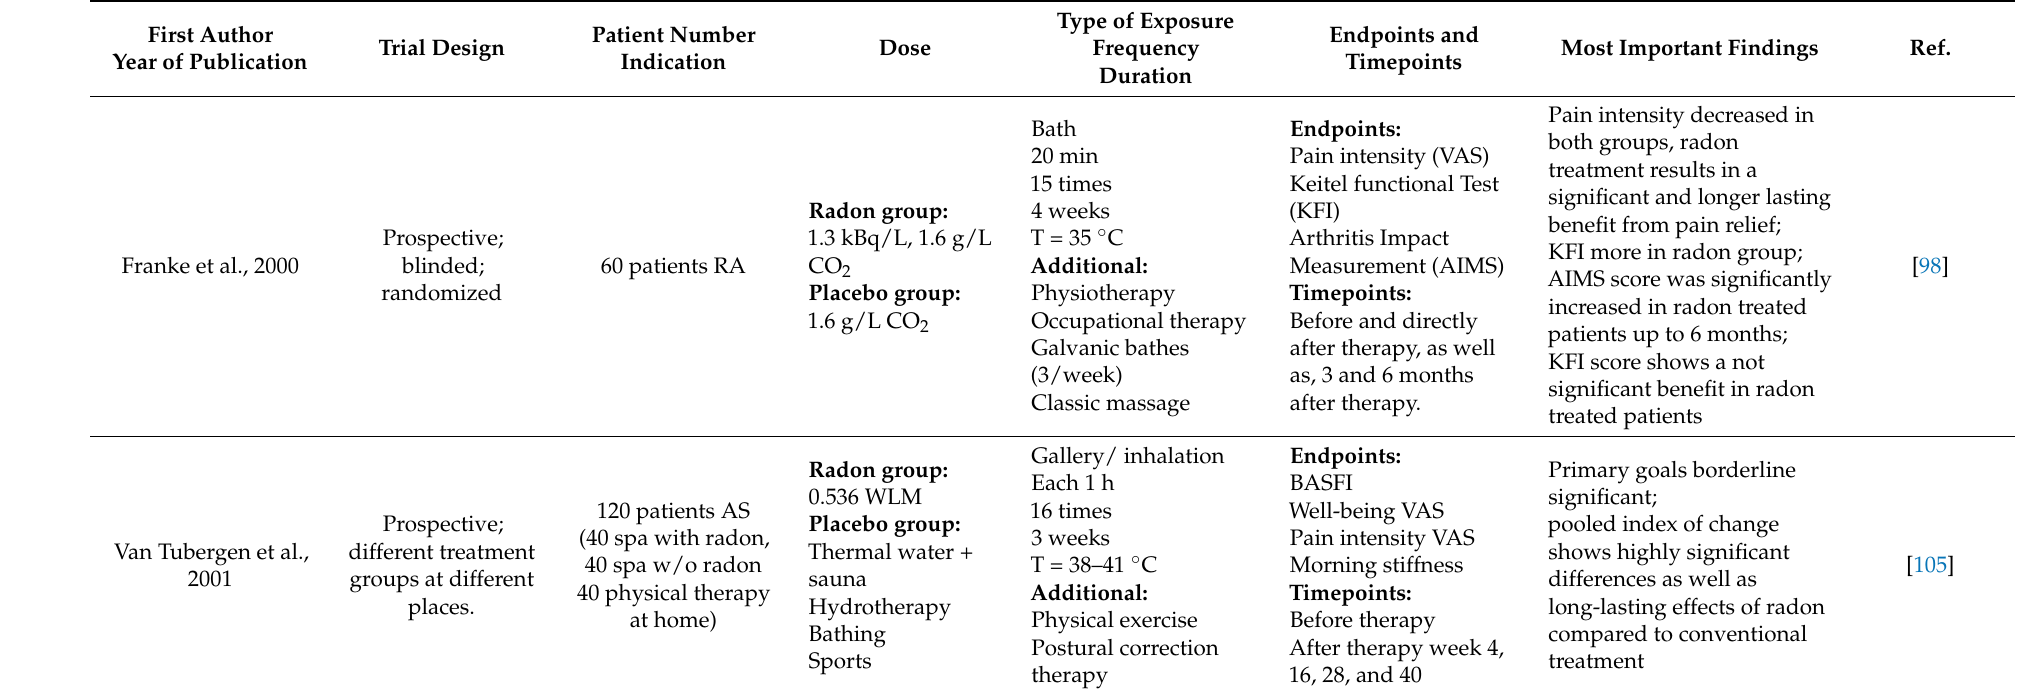
Table 3. Clinical trials with radon application from year 2000